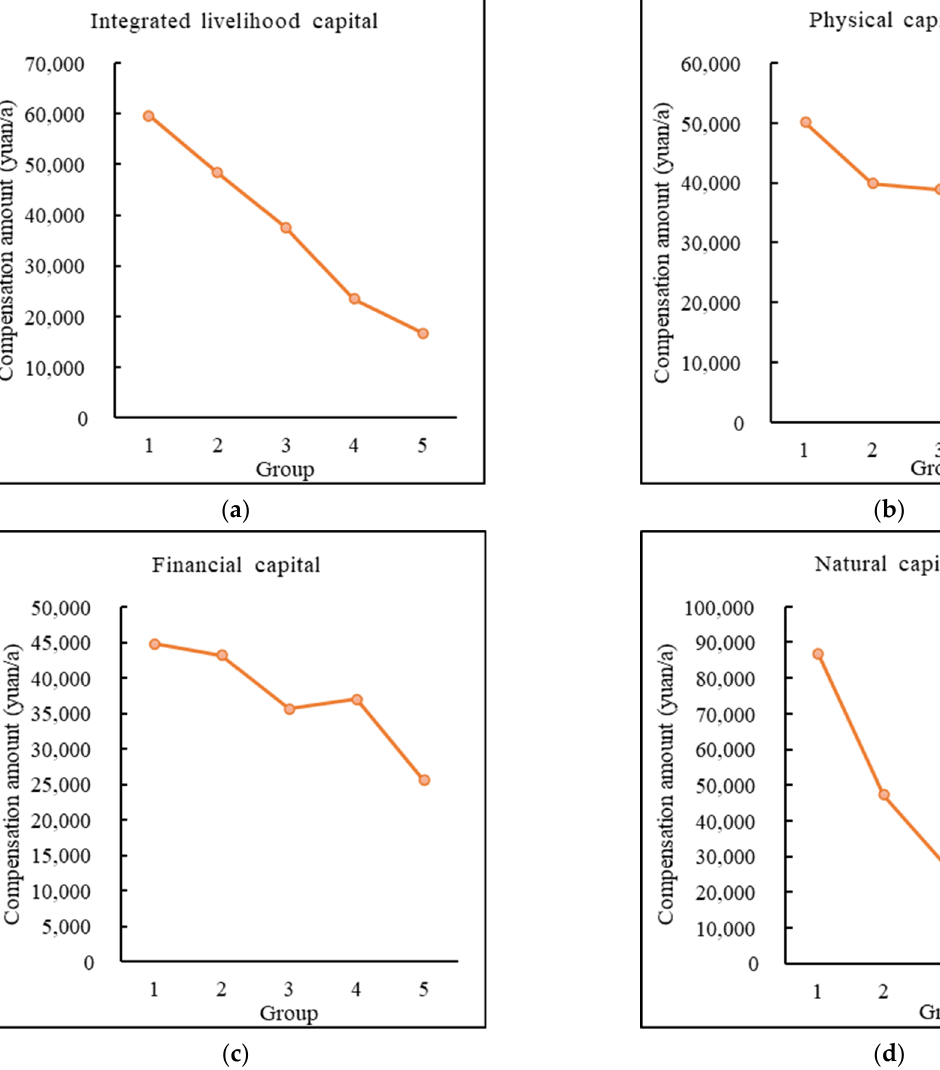
Figure 5. ( a ) Group comparison of herder households’ compensation amount based on integrated livelihood capital. ( b ) Group comparison of herder households’ compensation amount based on physical capital. ( c ) Group comparison of herder households’ compensation amount based on financial capital. ( d ) Group comparison of herder households’ compensation amount based on natural capital.